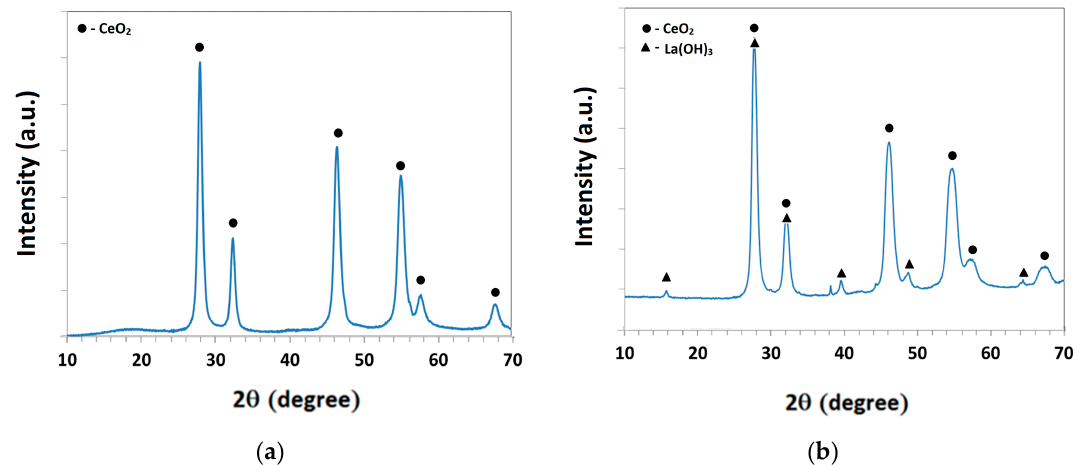
Figure 7. XRD patterns of acid leach residue samples after alkali treatment and water leaching. ( a ) Sample A is from plate glass polishing and ( b ) sample B is from mirror polishing.